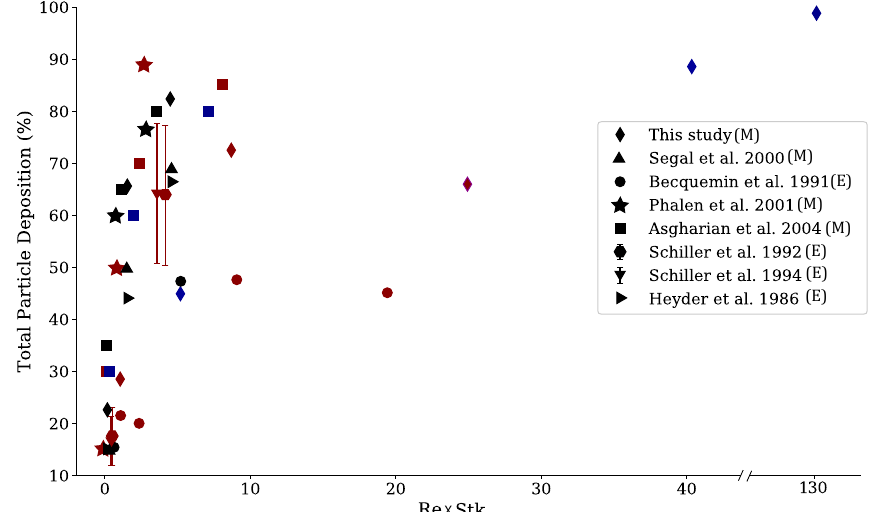
Figure 7. Total deposited dose for 1 µ m, 3 µ m, and 5 µ m diameter particles, with respect to Reynolds number ρ p d 2 p w 4 ρ Q mean Stk = ( Re = 18 µ d c , where d p is the particle diameter, ρ p is the particle density, π µ D trachea ) times Stokes number ( w the mean flow velocity, and d c the diameter of the airway), in both modeling (M) and experimental (E) studies. Infants are shown as blue, child as red, and adult subjects as black. Details on Re × Stk for each study are provided within the supplementary